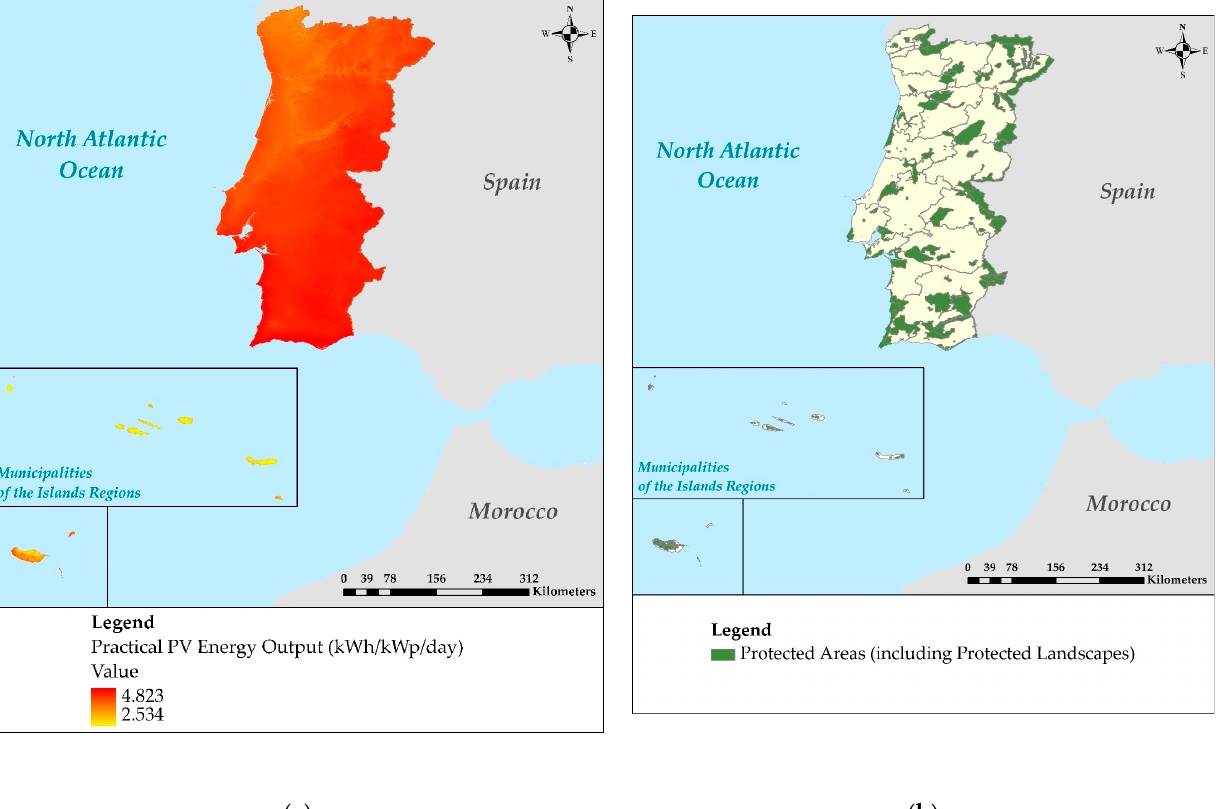
Figure 3. Thematic maps of ( a ) PVOUT (PVSC.2) and ( b ) distance from protected areas